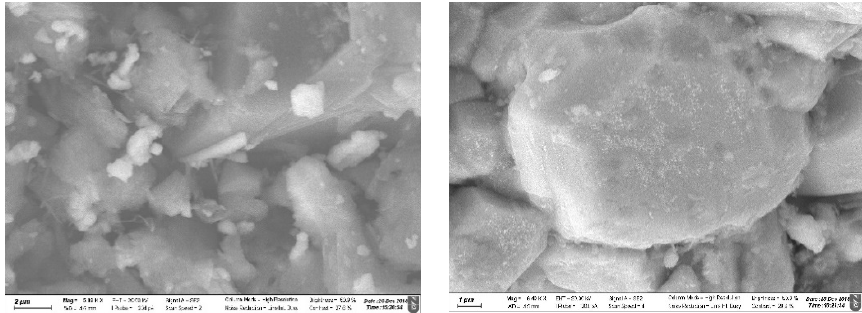
Figure 7. SEM images of Ag 2 O@NZU ( left ) and Ag 0 @NZU ( right ) samples (scale 1 ‐ 2 μ m).